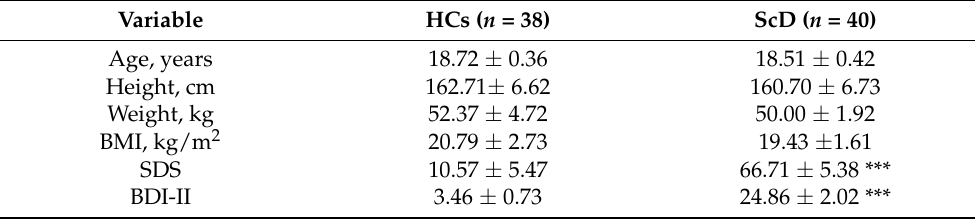
Table 1. Demographic information of participants (Mean ±